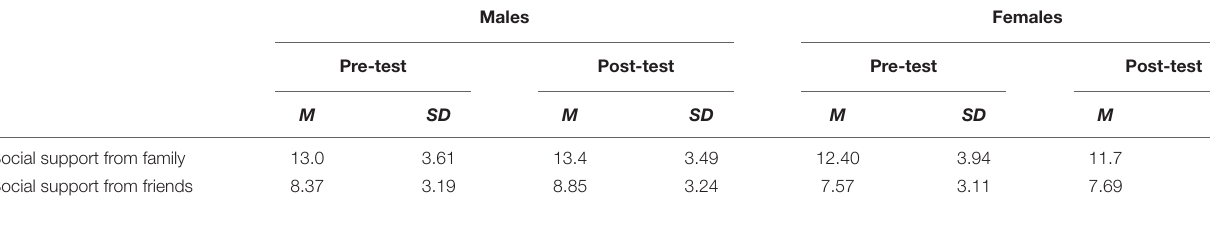
TABLE 3 | Mean and SD distinguished by gender between pre- and post-test. Males